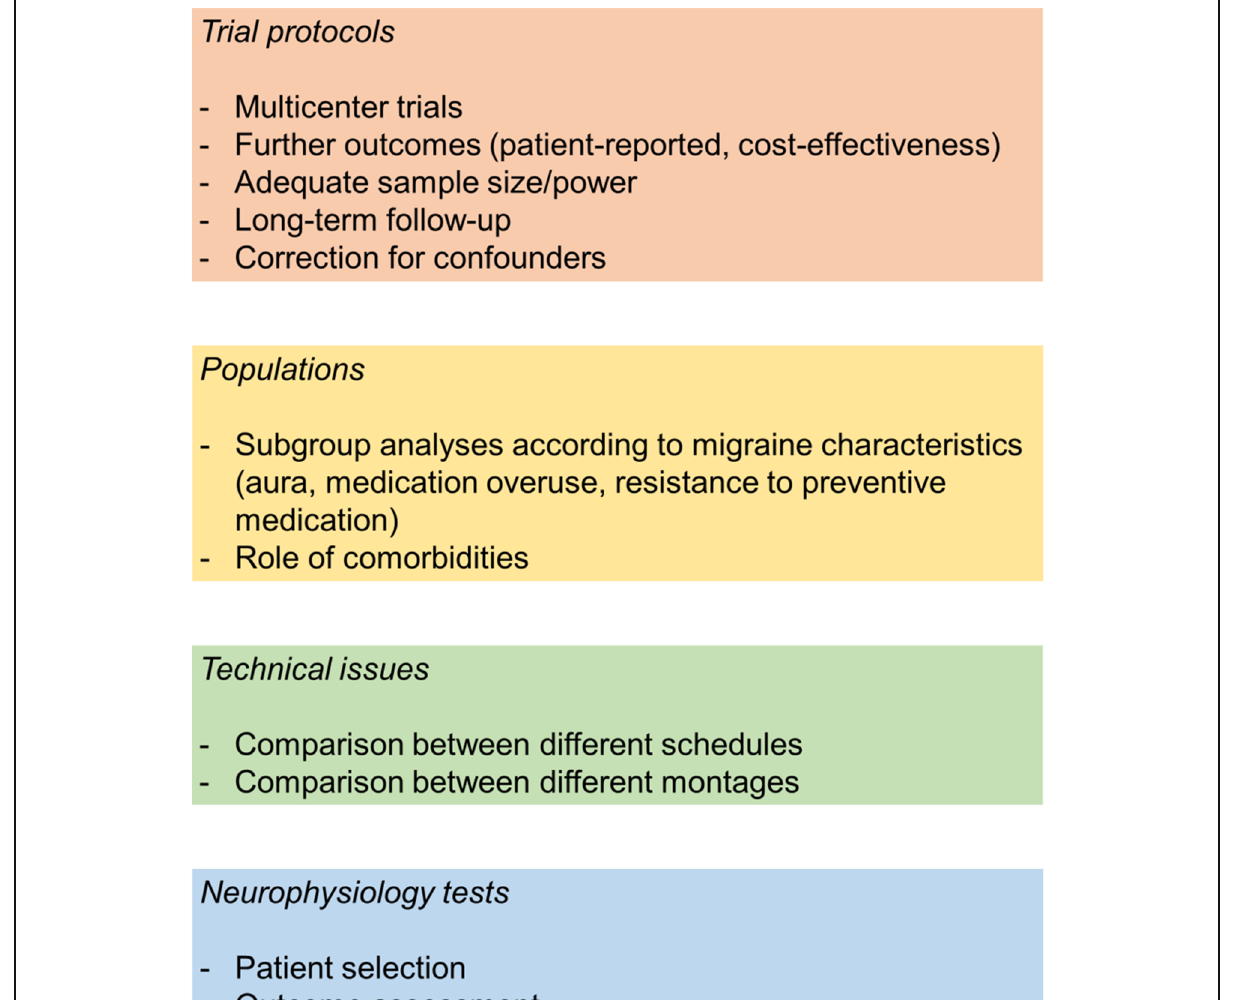
Fig. 7 Unmet needs in transcranial direct current stimulation trials for migraine